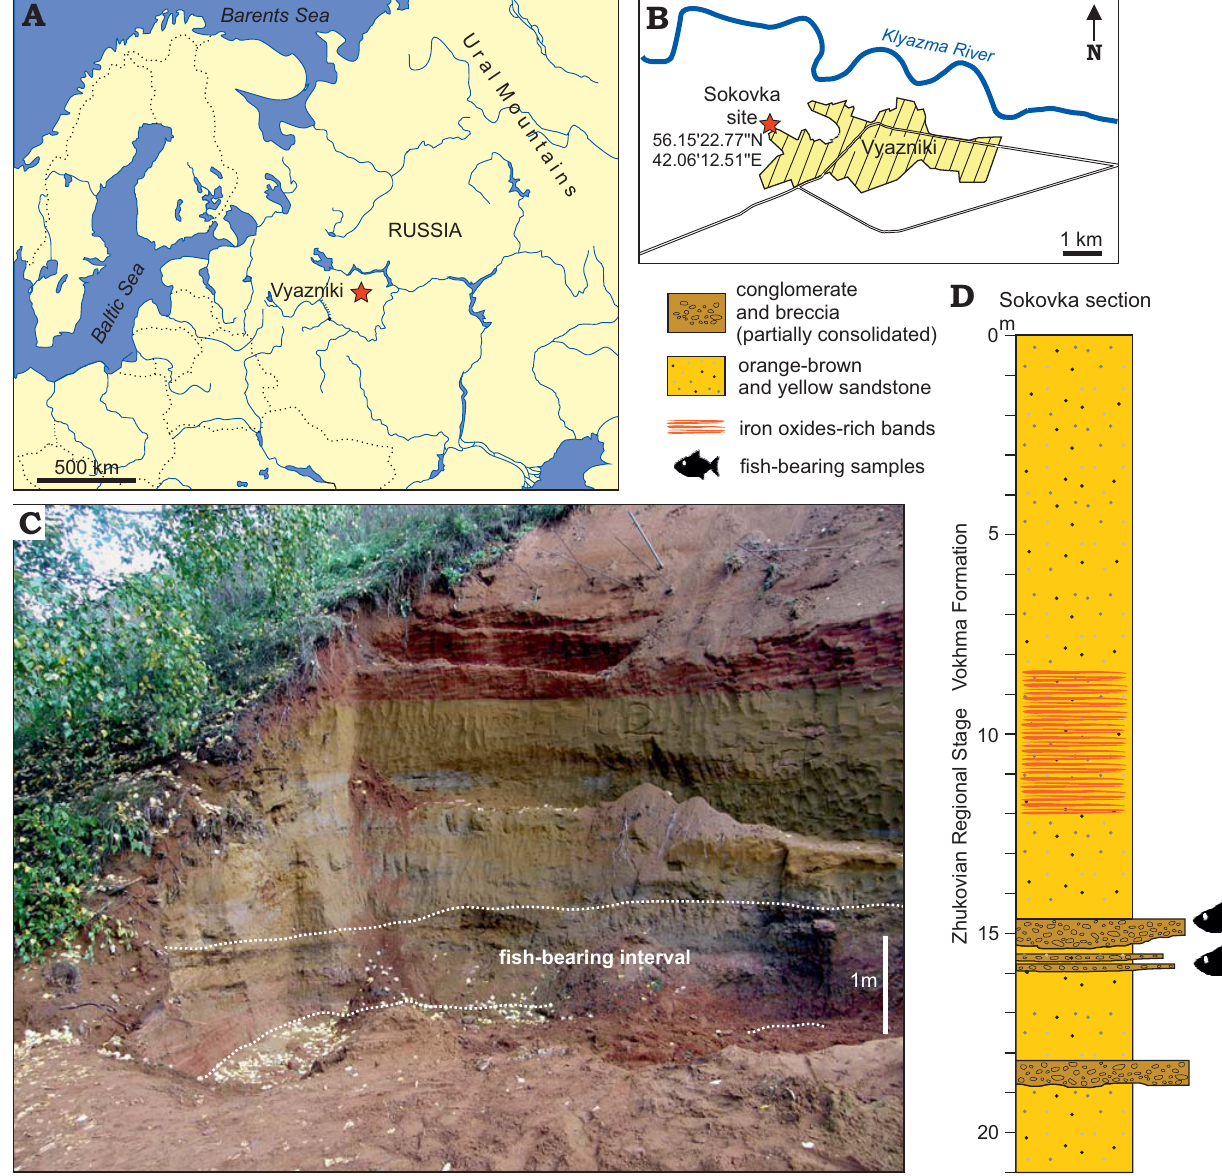
Fig. 1. Location of the fish-bearing site and details of the exposed section. A . Map of the Eastern Europe with position of Vyazniki (BY, Belarus, LV, Latvia; EST, Estonia; LT, Lithuania). B . The area around the town of Vyazniki with position of Sokovka site (star). C . Photograph of the Sokovka section from 2013 and exposure of the fish-bearing deposits. D . The simplified section from Sokovka site showing the fish-bearing layers. Modified from Newell et al. 2010, Owocki et al. 2012, and Bajdek et al.